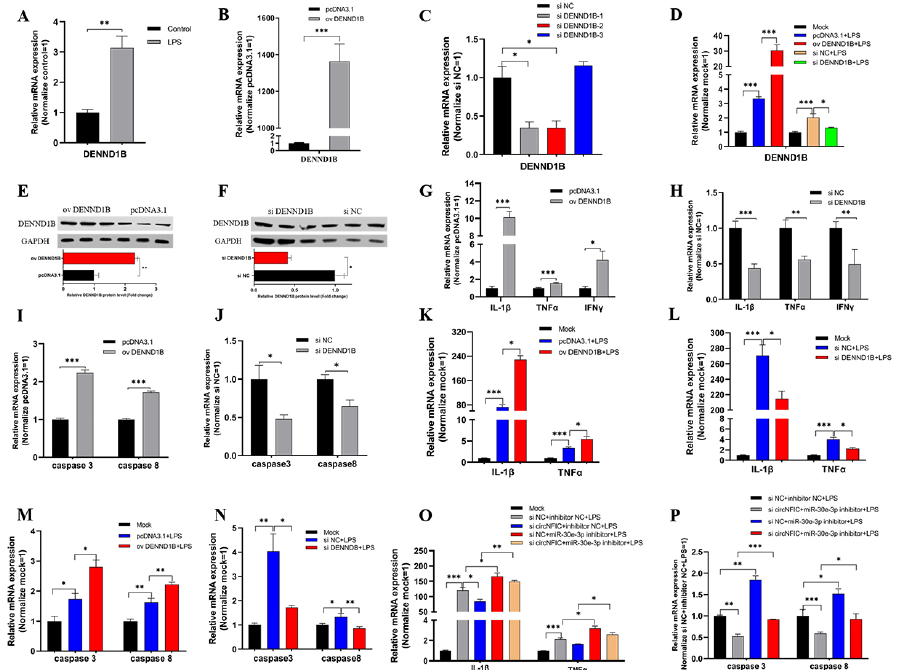
Figure 5. DENND1B induced inflammation and apoptosis in HD11. ( A ) The mRNA expression of DENND1B was induced by LPS stimulation. ( B ) The efficiency of overexpression and knockdown of DENND1B in HD11. ( C , D ) The efficiency of overexpression and knockdown of DENND1B in HD11 exposed to LPS. ( E , F ) The protein expression levels after overexpression and knockdown of DENND1B. ( G , H ) DENND1B induced the mRNA expression levels of pro-inflammatory factors (IL-1 β , TNF α , and IFN γ ). ( I , J ) DENND1B promoted the expression levels of pro-apoptosis maker genes (caspase 3 and caspase 8). ( K , L ) The expression of IL-1 β , TNF α , and IFN γ could also be regulated by DENND1B in HD11 exposed to LPS. ( M , N ) DENND1B also could up-regulate the mRNA expression of pro-inflammatory factors and pro-apoptosis maker genes in HD11 exposed to HD11. ( O , P ) Inhibitor of miR-30e-3p could rescue the down-regulation on pro-inflammatory factors and pro-apoptosis maker genes of knockdown of circNFIC in HD11 exposed to LPS. Data were presented as mean ± SEM (n ≥ 3 biologically independent samples). * p < 0.05; ** p < 0.01; *** p < 0.001 (Student’s t